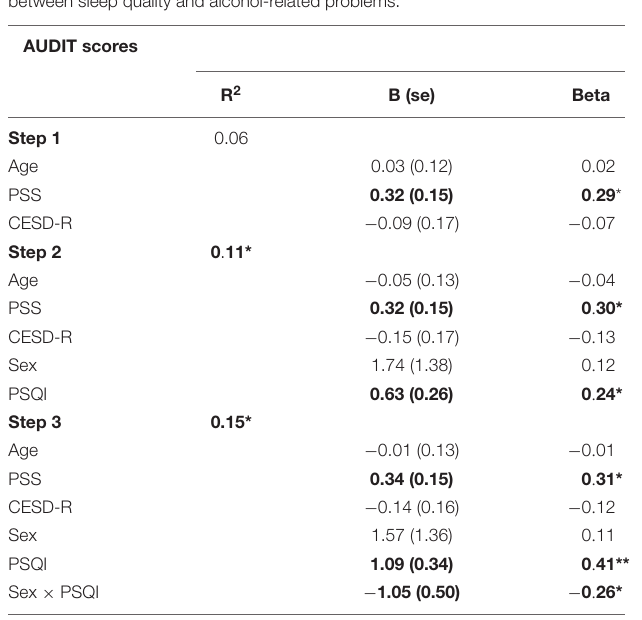
TABLE 2 | Hierarchical regression analysis of sex differences in the relationship between sleep quality and alcohol-related problems.